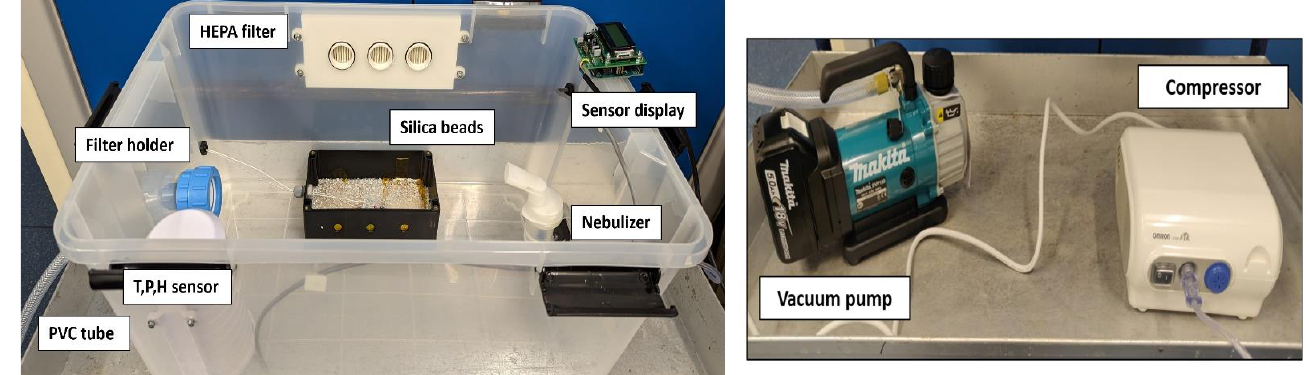
Figure 2. Laboratory-built portable bioaerosol chamber. This portable system consists of a filter holder that holds nucleopore filters of 47-mm diameter attached to a vacuum pump that helps bioaerosol suction. A nebulizer connected to a compressor generates the aerosols. The HEPA filter draws in clean air and stabilizes the pressure within the box.